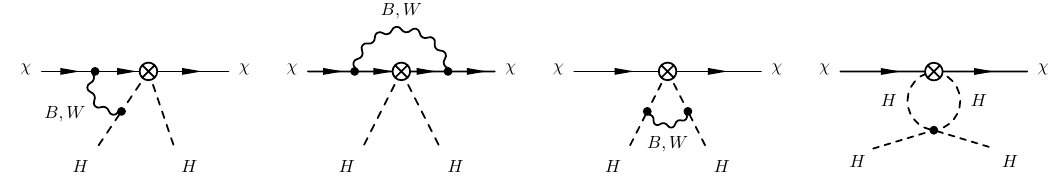
Figure 4 . Sample diagrams for renormalization of Q 0 (5) at one loop.